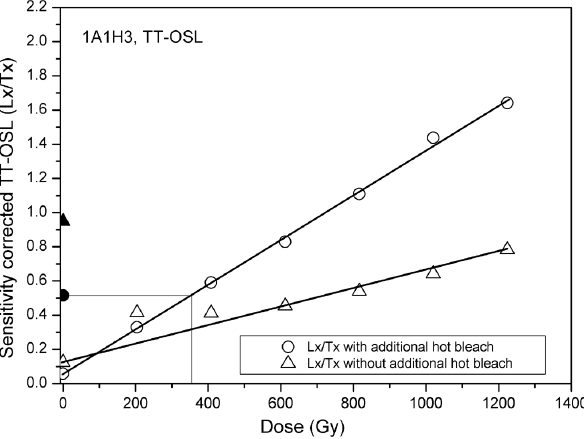
Fig. 5. Dose recovery pre-heat plot on sample 1A1H2 with the SAR-IRSL 50 protocol. Samples were first bleached by a 300s shine down at 50 ◦ C to reset the natural luminescence signal and then ir- radiated with a 206Gy beta dose. Four sub-samples each were mea- sured at five different temperatures and yielded a perfect match at 270 ◦ C with the given dose (ratio is 1.01, see inset), if a single ex- ponential plus linear function is fitted for D e